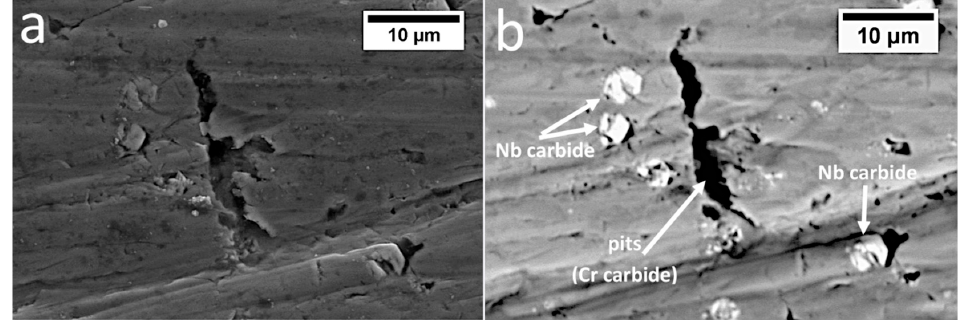
Figure 14. Area of layer I. ( a ) Topographic contrast (SE detector). ( b ) Material contrast (BSE detector). Visible pits caused by chromium carbide spalling and firmly embedded niobium carbides. Scanning electron microscopy.